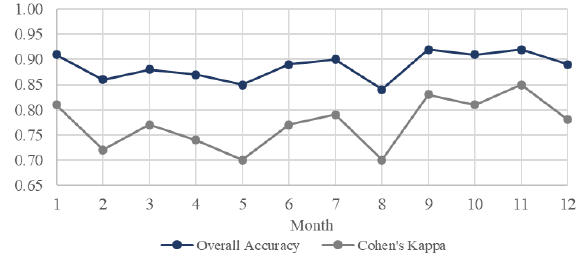
Figure 6. Overall accuracy and Cohen's Kappa from the internal validation for each month under consideration.